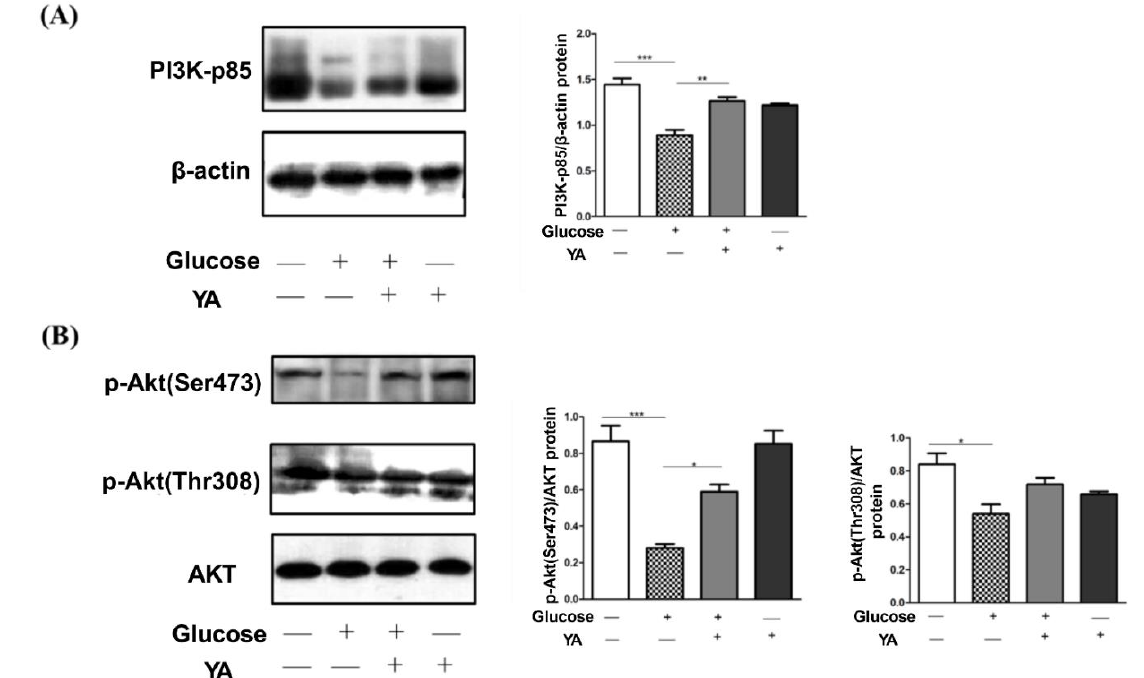
Figure 4. Effects of YA treatment on PI3K/Akt signaling pathway in INS-1 cells. INS-1 cells were treated with 40 µM YA and 40 mM glucose for 24 h, the PI3K ( A ) and phosphorylation of Akt473/Akt308 ( B ) were detected using Western blot. Equal amounts of proteins from each sample were separated on SDS-PAGE. Phosphorylation of Akt473/Akt308 was probed by p-Akt (Ser 473) and p-Akt (Thr 308) antibody. PI3K was probed by PI3K-p85 antibody. Total β -actin and Akt were taken as two control groups separately. Values are means ± SD from three representative experiments ( n = 3). (* p < 0.05 vs. glucose, ** p < 0.01 vs. glucose, *** p < 0.001 vs. glucose).